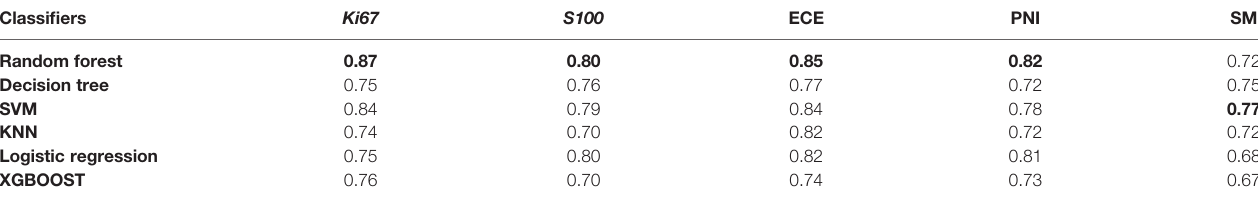
TABLE 3 | AUCs of different MP-MRI radiomic classi fi ers for predicting the fi ve biological characteristics in the validation cohorts. Classi fi ers Ki67 Random forest